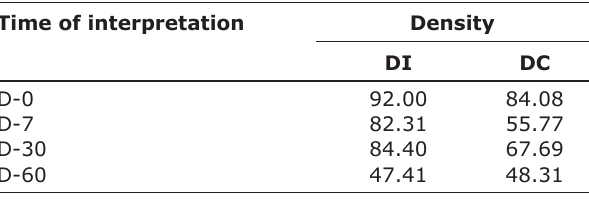
Table-4: Radiographic density of implant (arbitrary unit) based on time of interpretation (days).